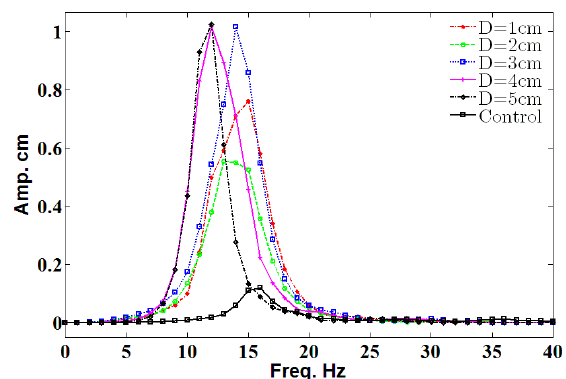
Figure 7. The amplitude value for different diameters in a distance of 10 cm.